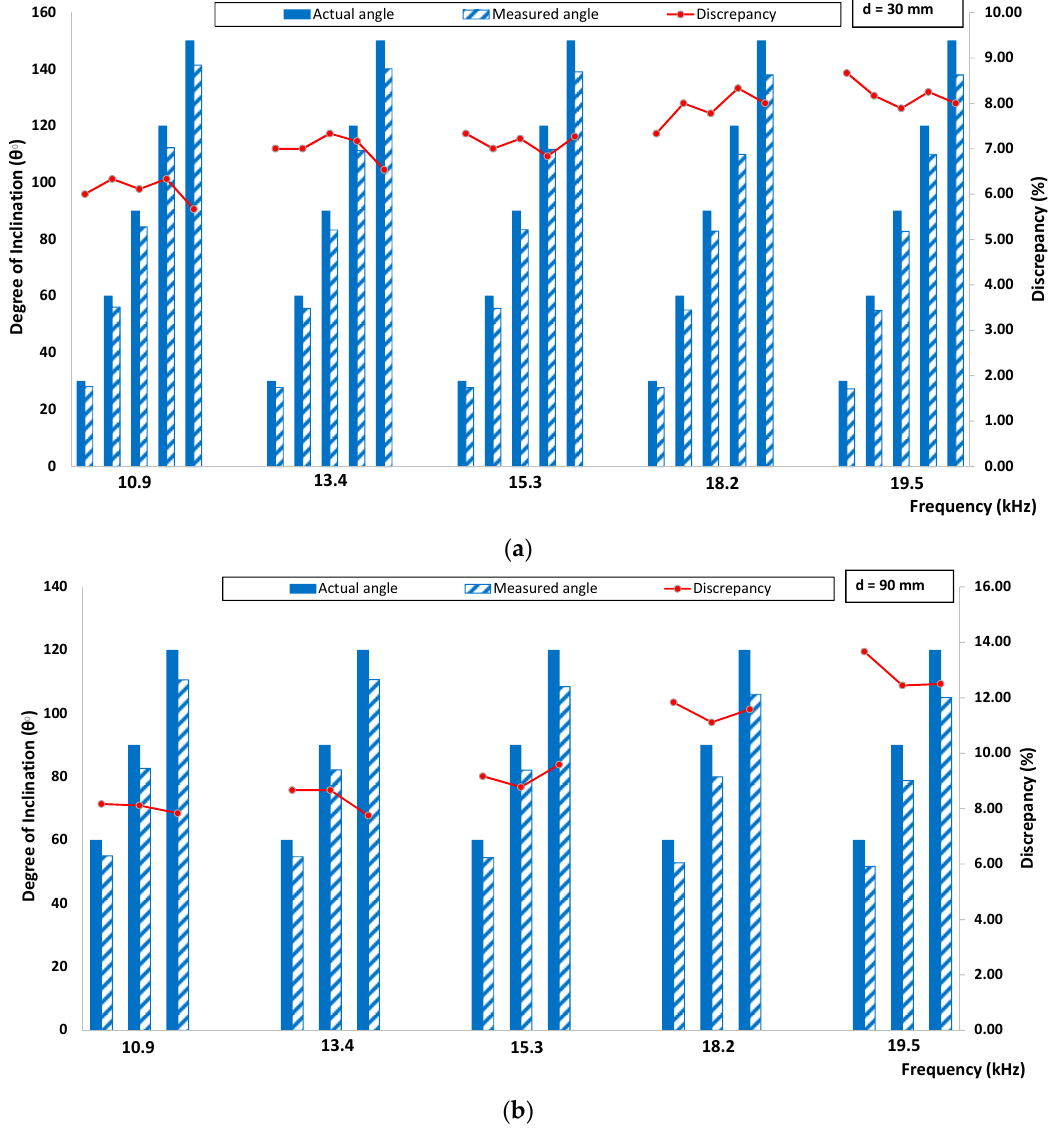
Figure 15. Comparison between actual and experimentally measured degree of inclination based on velocity index for ( a ) 30 mm crack depth and ( b ) 90 mm crack depth.